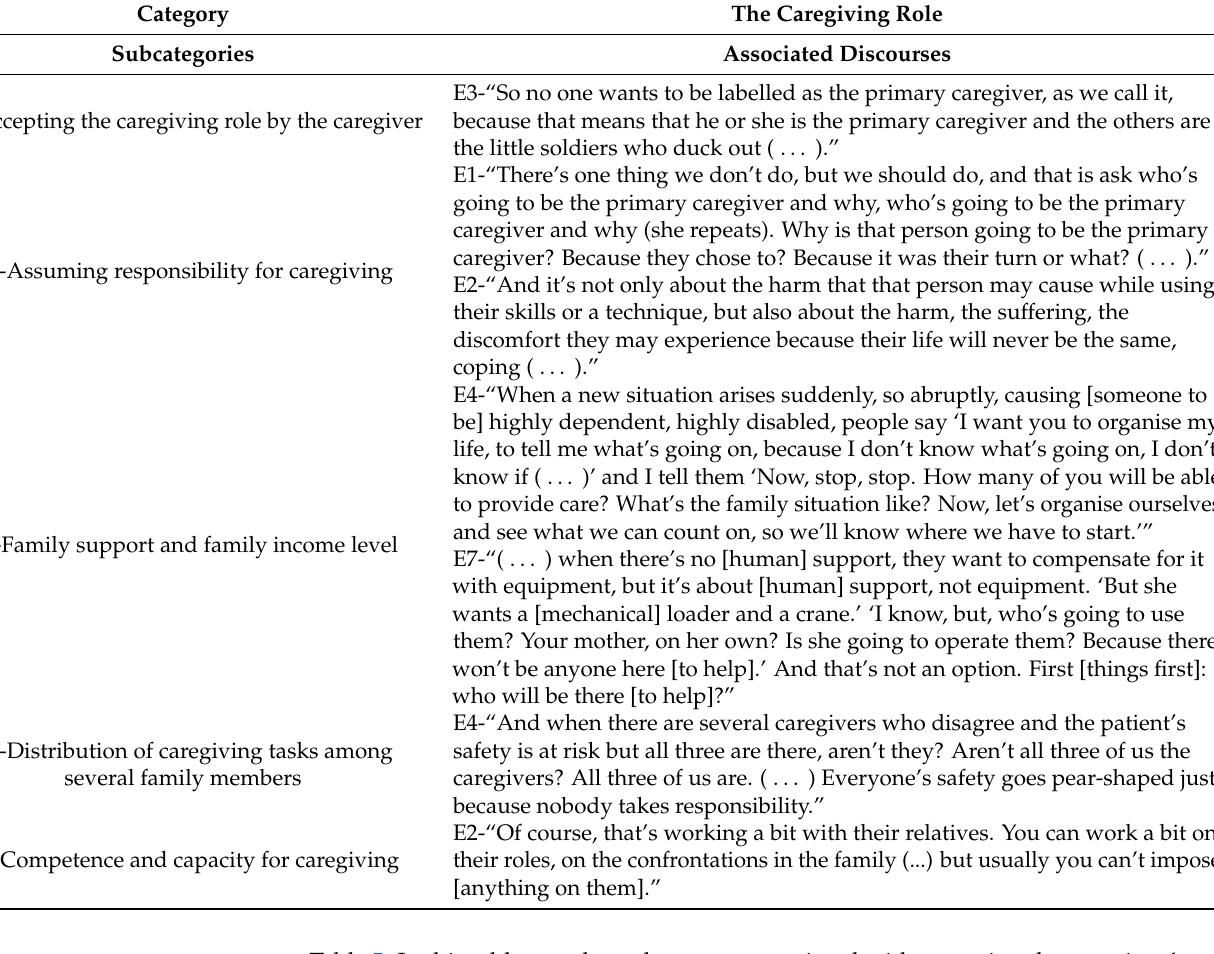
Table 5: In this table, we show the aspect associated with accepting the caregiver’s role, assuming the responsibility for caregiving, and some other FCs’ and family’s characteristics, which are formatted this category, called “The caregiving